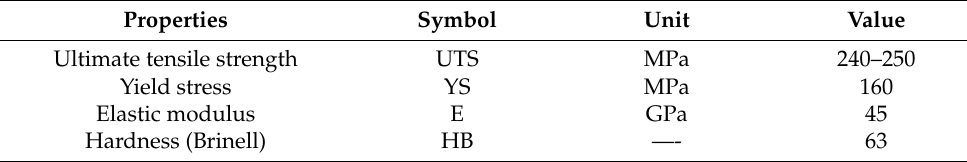
Table 10. Mechanical properties of AZ91 magnesium alloy